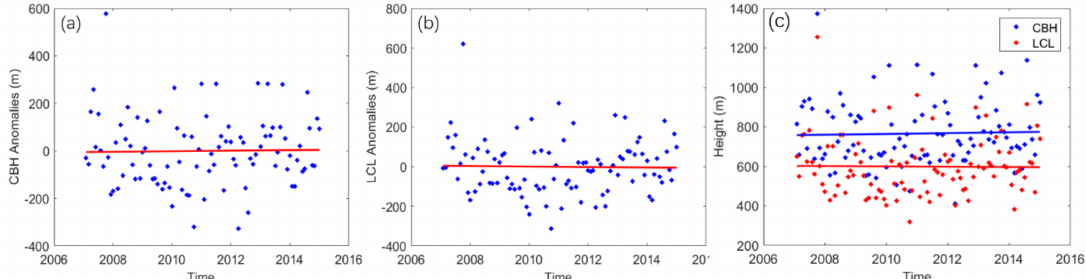
Figure 2. Monthly anomalies of ( a ) cloud base height (CBH); ( b ) lifting condensation level (LCL); and ( c ) monthly average cloud base height and lifting condensation level at BWI station.